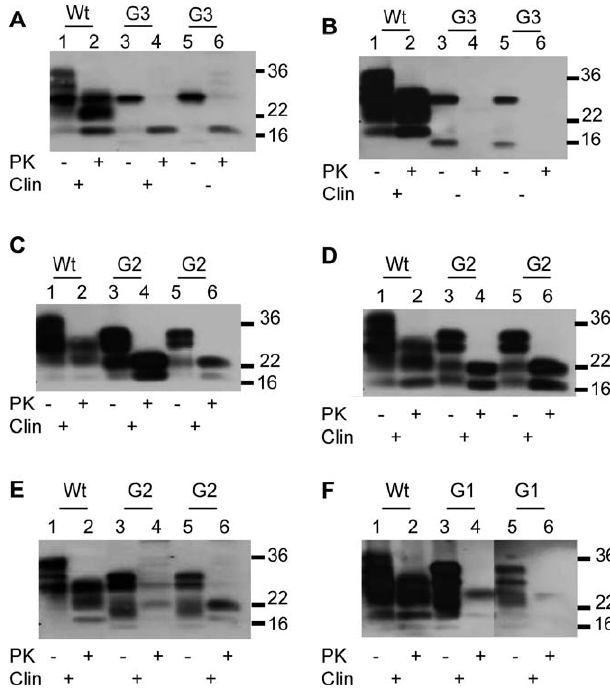
Figure 1. Western Blot Analysis of Brains from TSE Inoculated Glycosylation Mutant Mice Brain homogenates were treated with or without PK as indicated prior to SDS PAGE